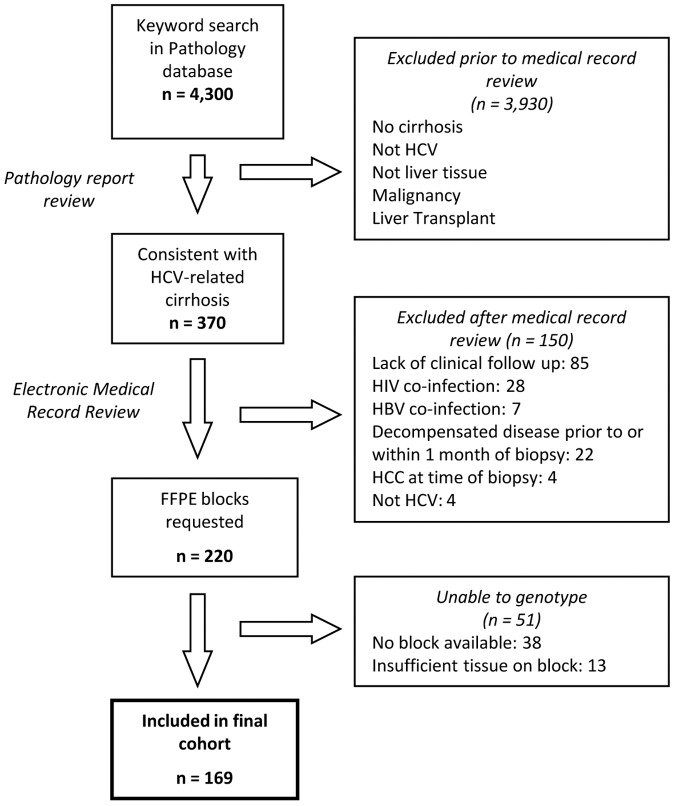
Flow chart for identification of the cohort.The following keywords were used in the pathology database search: HCV, HBV, NAFLD, NASH, and hepatitis. HCV: hepatitis C virus; HBV: hepatitis B virus; HIV: human immunodeficiency virus; HCC: hepatocellular carcinoma; FFPE: formalin-fixed, paraffin-embedded;